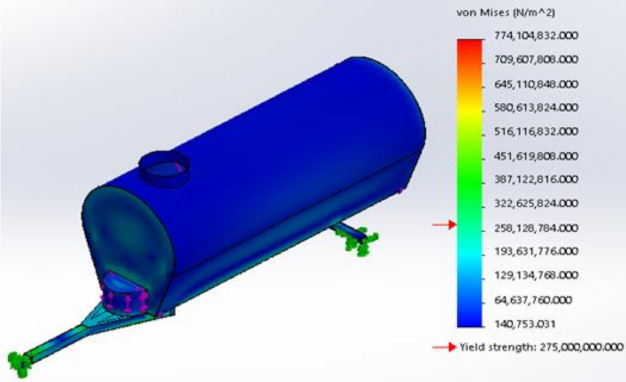
Figure 11. Stress distribution on the body of the